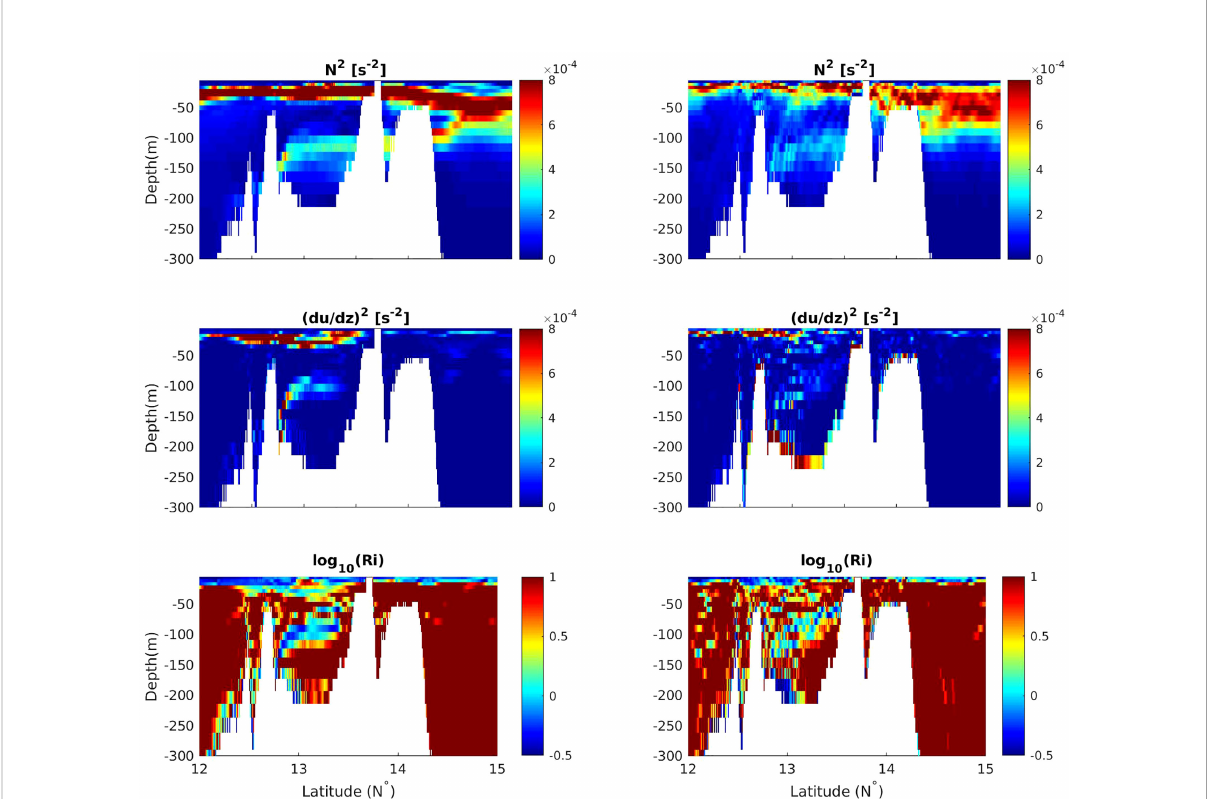
FIGURE 8 The square for buoyancy frequency (N 2), the square for the vertical gradient of the along- axis velocity ((du/dz)2) and the base ten logarithm of Richardson number are presented from top to bottom.(log10(Ri)). The left panels show the run without tides and the right panels show the run with